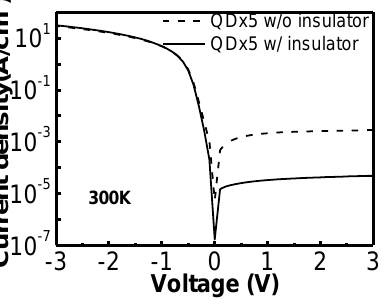
Figure 25. Dark currents of five-period SiGe/Si QDIPs with and without an insulator layer between the metal and semiconductor. A QD sample with the insulator layer indeed can reduce the dark inversion current. Reproduced from [80] with permission of Elsevier (2006).